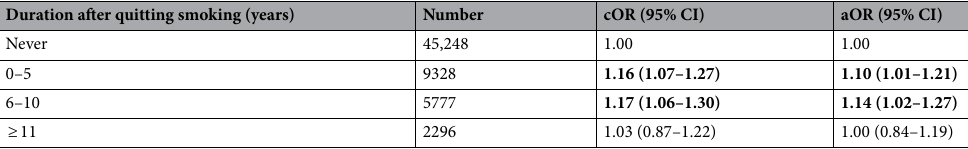
Table 3. Association between duration of smoking cessation and the risk of bronchial asthma at the age of 3 in mothers who quit smoking before pregnancy. cOR, crude odds ratio; aOR, adjusted odds ratio; CI, confidence interval. Boldface indicates statistical significance ( p < 0.05). Adjusted for partner’s smoking status before birth, frequency of second-hand smoke exposure during pregnancy, maternal history of bronchial asthma, maternal age at birth, pre-pregnancy body mass index, maternal educational level, child’s sex, gestational age at birth, mode of delivery, attendance to childcare facility at 1 year of age, breastfeeding at 1 year of age, and older siblings.